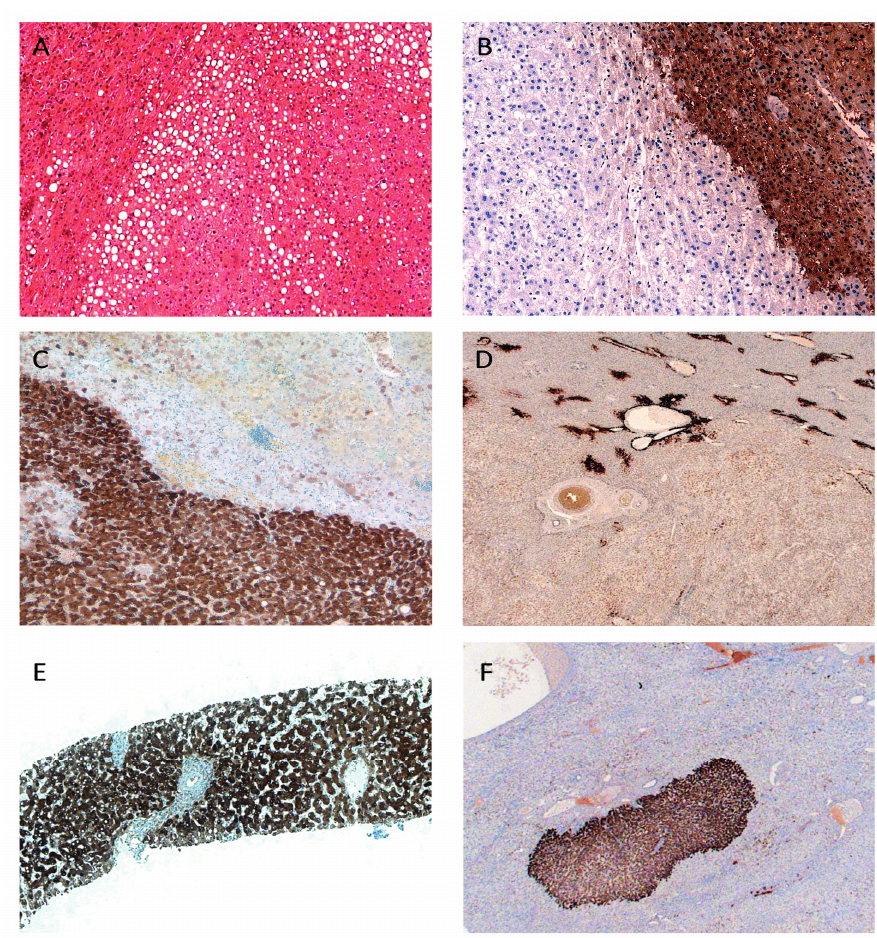
Figure 3. Immunohistochemical features of hepatocellular adenoma subtypes. Typically, HNF1 α inactivated HCA (H-HCA) display plurivesicular steatosis as seen on this biopsy ( A ); together with loss of FABP in immunohistochemical stains on the resection specimen of the same tumor ( B ); bHCA feature diffuse and intense GS staining if a CTNNB1 Exon 3 mutation is present ( C ); staining is only faint in cases with CTNNB1 Exon 7/8 mutation ( D ); inflammatory HCA are characterized by strong and uniform immunohistochemical CRP staining ( E ) together with sinus dilation and inflammatory infiltrates. Frequently, the vicinity of an inflammatory HCA shows small neoplastic foci of CRP staining consistent with microadenomas ( F ). CRP: C-reactive protein; GS: glutamine synthetase; FABP: fatty acid binding protein